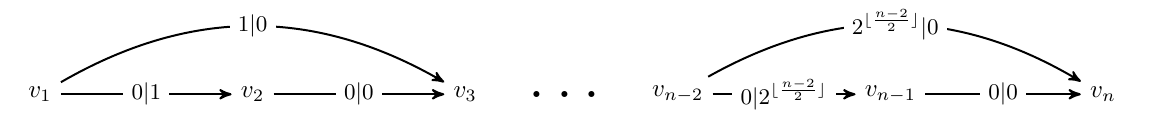
Figure 4. General EXP instance. Every path is